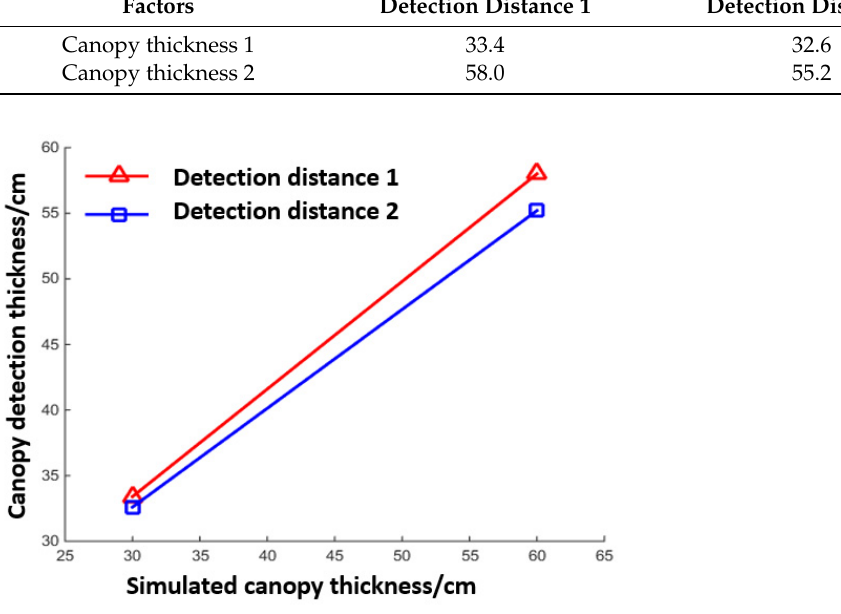
Figure 10. Diagram of the interaction between detection distance and canopy